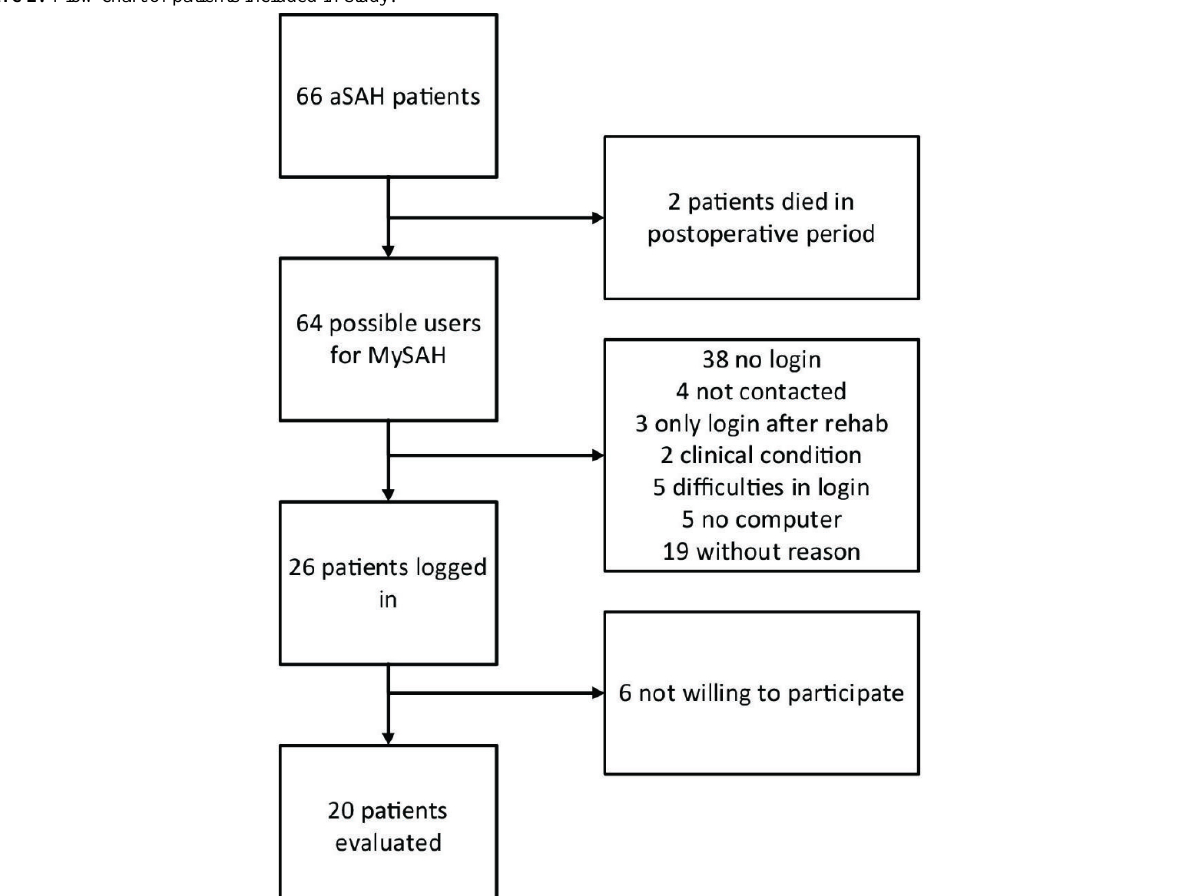
Figure 2. Flow chart of patients included in